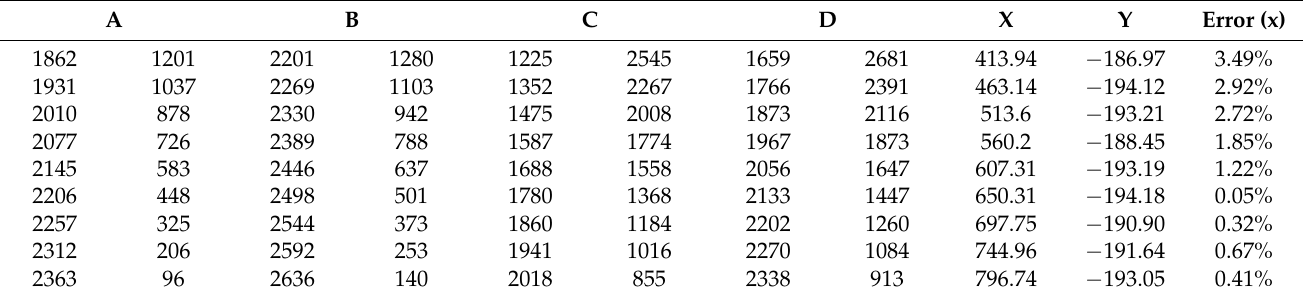
Figure 11. ( a )The model truck photographed by the camera in Test 2. ( b )Trajectory of model truck in Test 2. Table 2. Pixel coordinates of four selected points and identification results in Test 2.